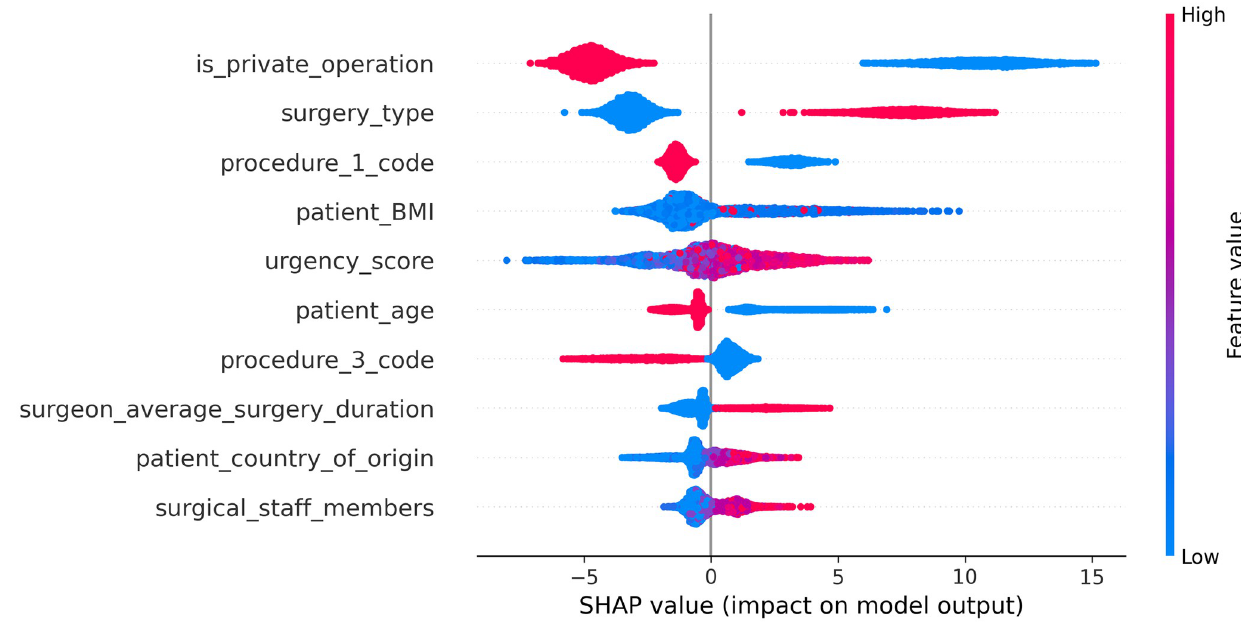
Fig 4. SHAP—DOSFM.